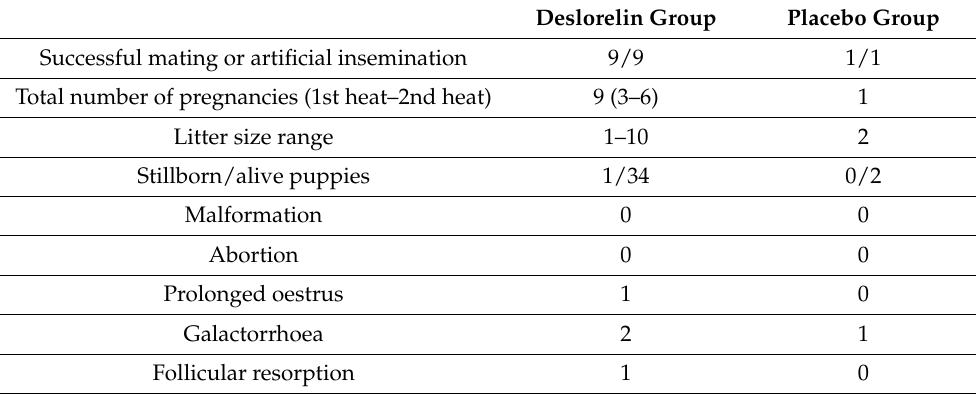
Table 2. Description of the reproductive performances in the animals of the deslorelin and placebo groups over up to 24 months after the occurrence of the first